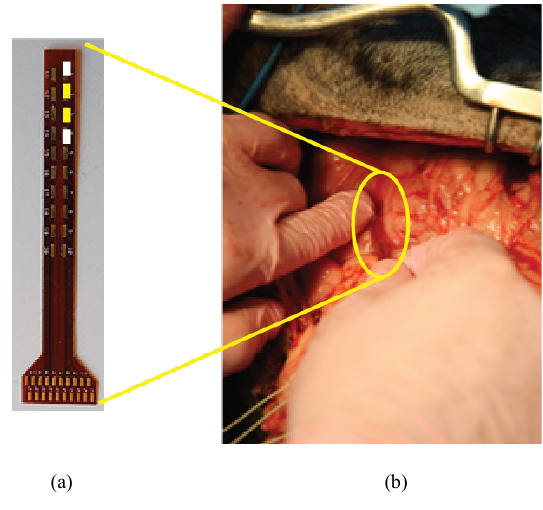
Fig. 4. Electrode placement. (a) is the electrode array that is described in section IIA, and shown in Fig. 2. Four total electrodes are used. The top and bottom white electrodes are H_CUR and L_CUR and are connected to ground electrodes, while the center yellow electrodes are H_POT and L_POT, the sense electrodes. (b) The electrode array is manually applied to the tissue for measurements.